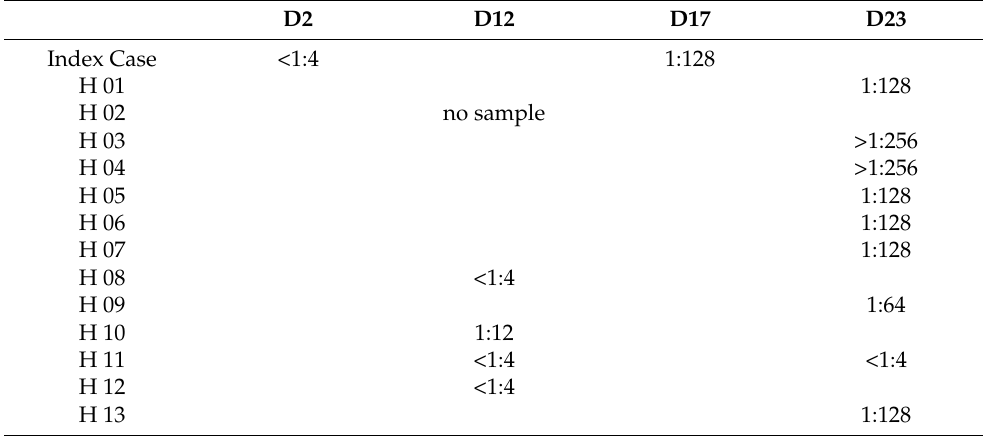
Table 2. Serology data on select